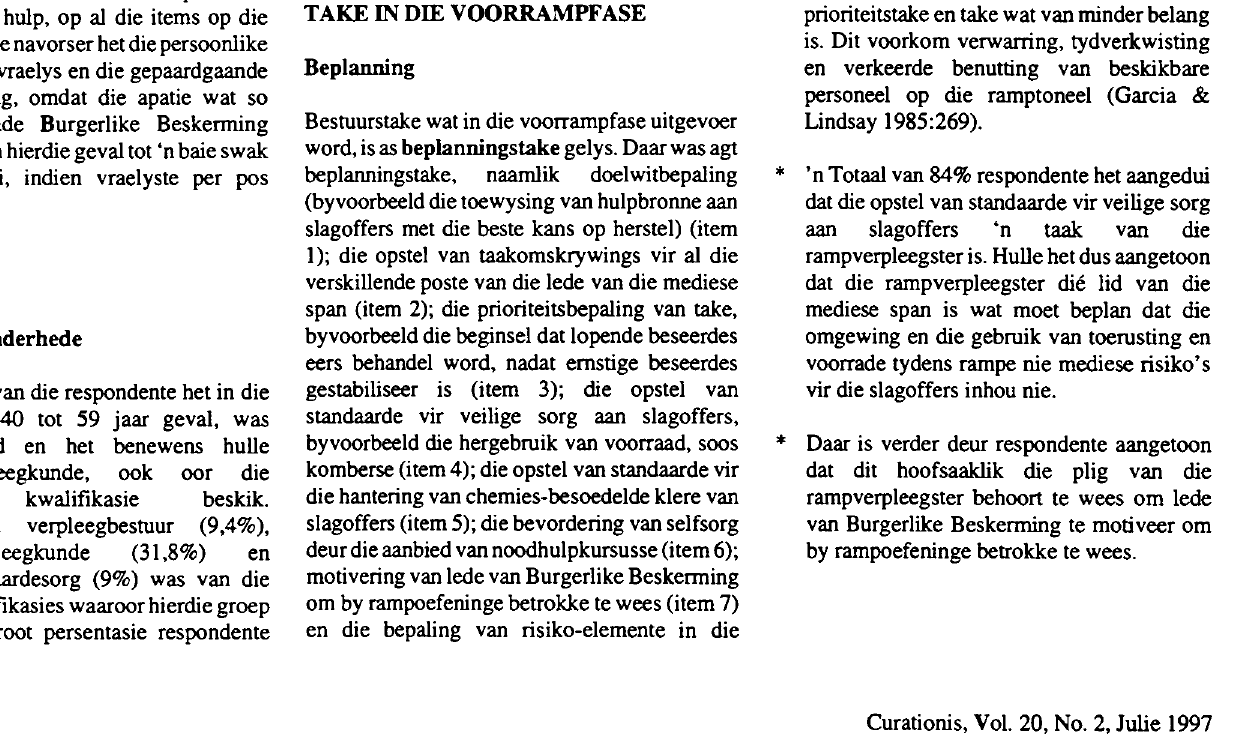
FIGUUR 1: DIE RAMPBESTUURSPROSES AS TERREIN VAN ONDERSOEK IN HIERDIE STUDIE (60%) het minder as 1 jaar ervaring gehad in die areas van ongevalle, ortopedie, intensiewesorg en buitepasiente. Die meerderheid respondente, naamlik 88% het verpleegbestuurservaring gehad op die van die posvlak van